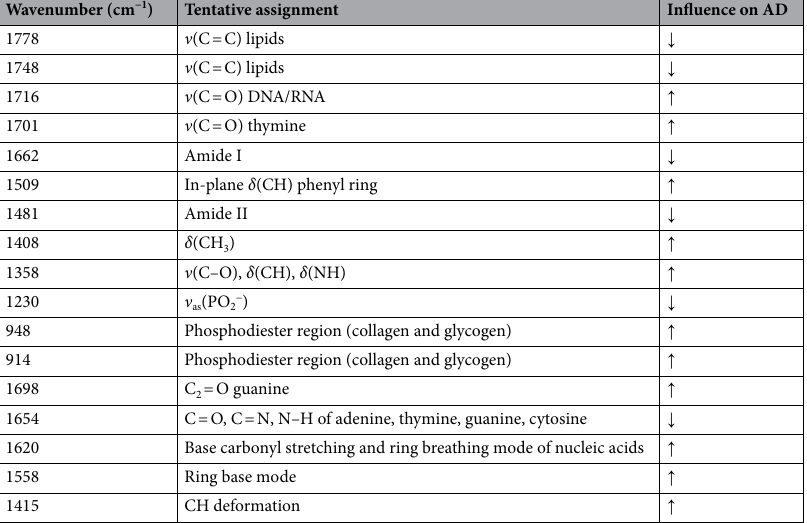
Wavenumber (cm −1 ) Tentative assignment Influence on